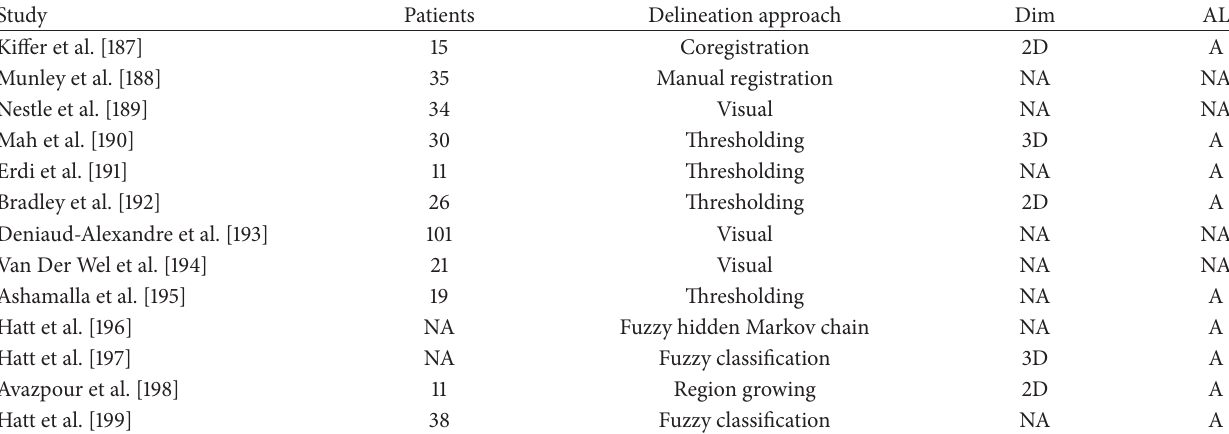
Table 6: Summary of lung nodule segmentation approaches from PET images. For each study, the table summarizes the number of the patients enrolled in the study and the type of the nodule delineation approach with respect to the methodology, the approach dimension, and the automation